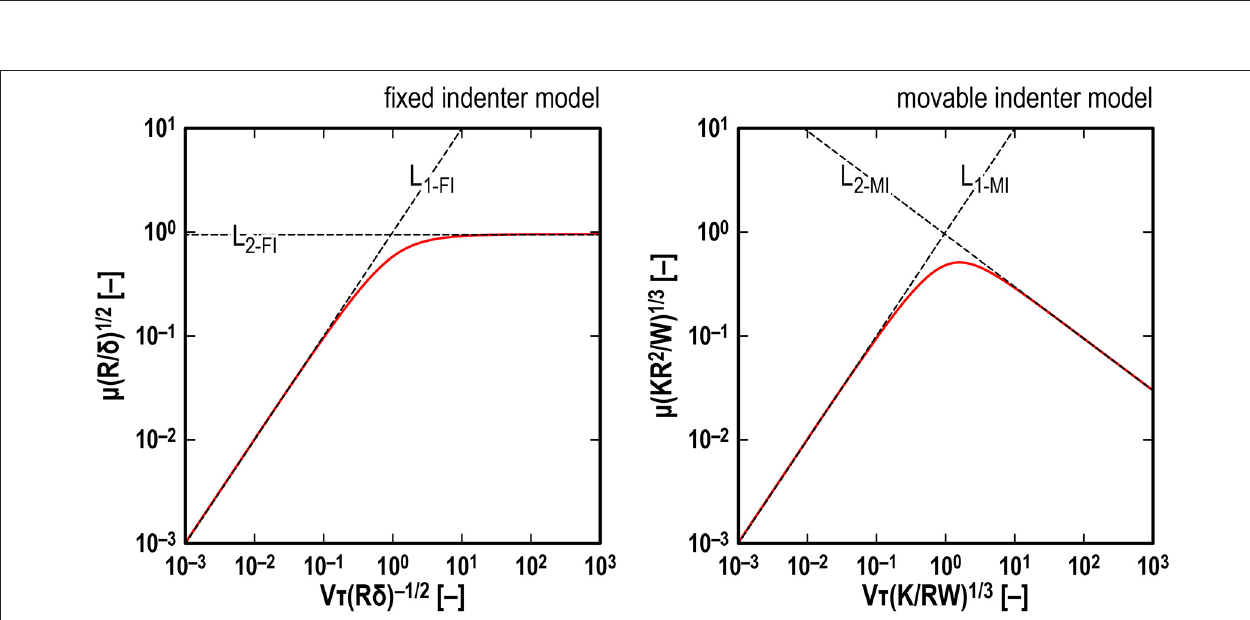
FIGURE 5 | Numerical results in steady sliding for fixed indenter model (Left) and movable indenter model (Right) : effects of retardation time τ on velocity dependences of indentation depth δ (Top) , normal load W (second row), friction force F (third row), and friction coefficient µ (bottom row). Black lines, τ blue lines, τ 10 − 1 s; red lines, τ 10 0 s (see Table 1 for other parameter values). = =